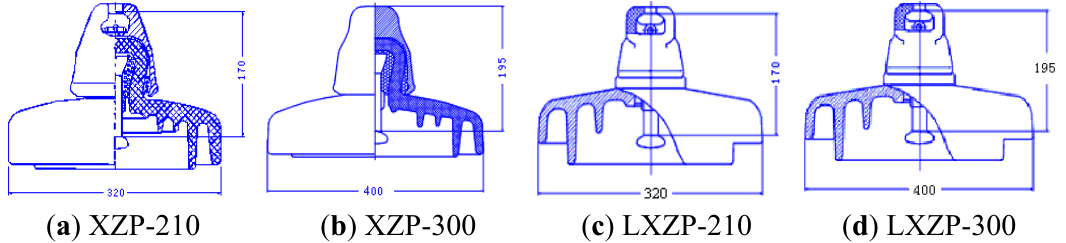
Figure 4. Profiles of test composite